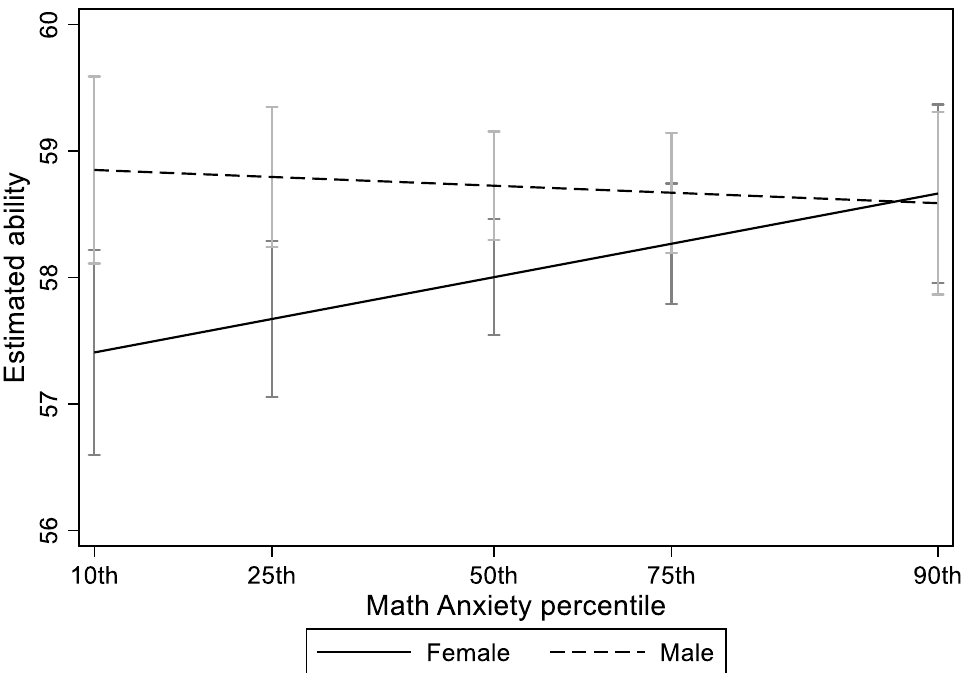
Fig. 6 Teachers’ math anxiety as a moderator of their ability ratings of boys and girls for the same student work. The bars indicate of the